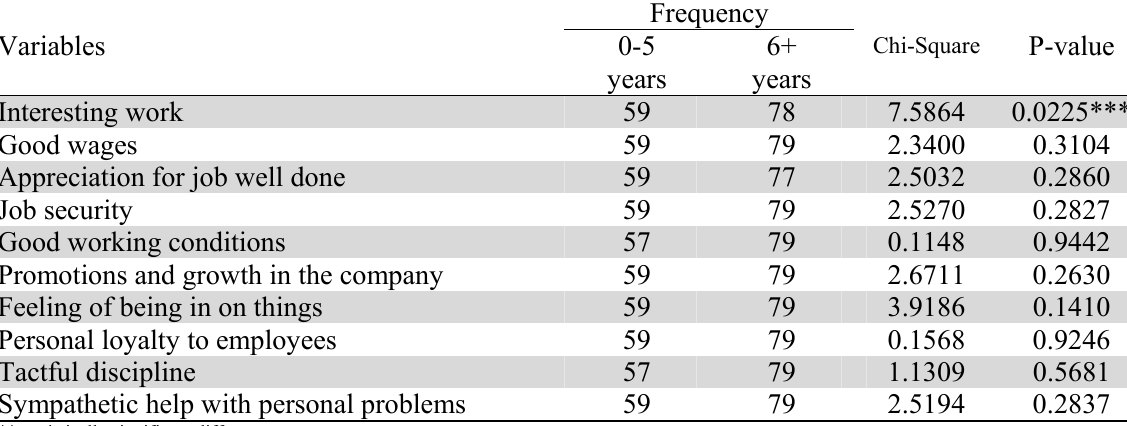
Chi-square test for the Years working